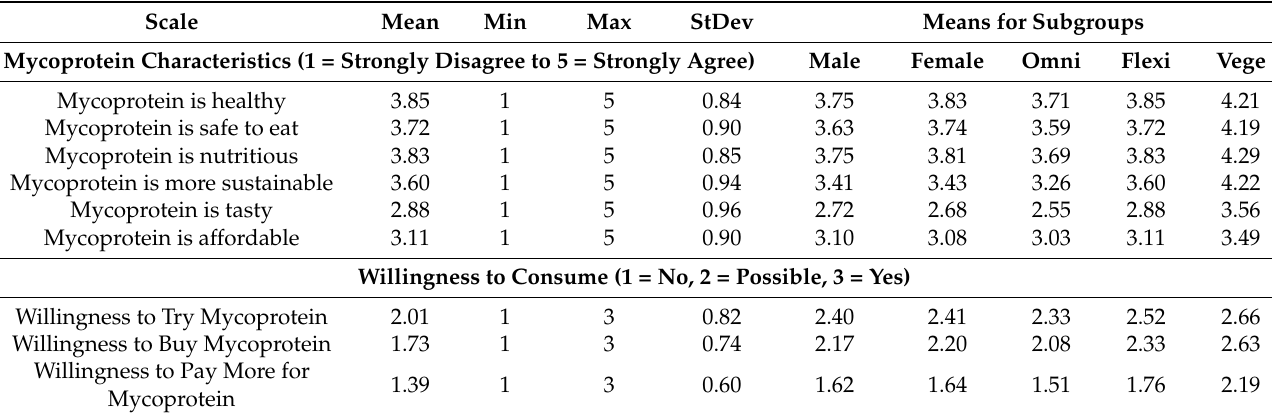
Table 2. Descriptive Statistics for Single-Item